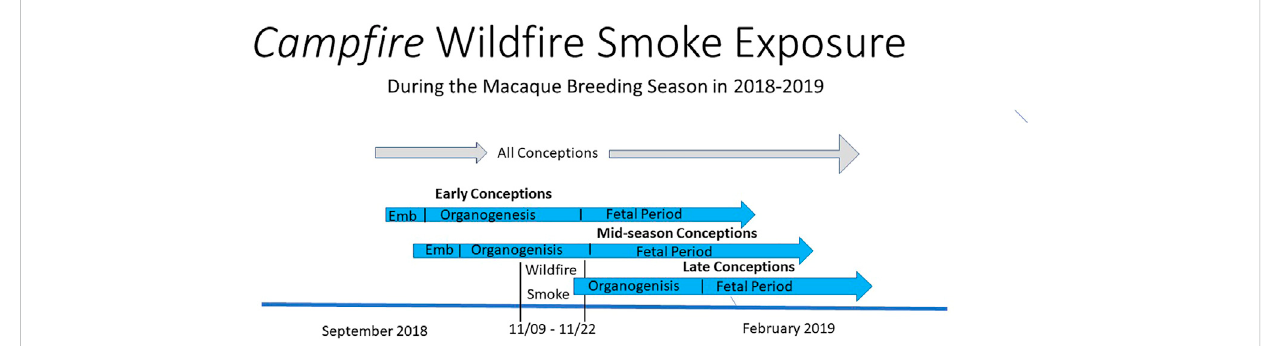
FIGURE 1 Timeline for the gestation periods: gestation periods and wild fi re smoke exposure for the outdoor breeding colony during the Camp fi re wild fi re in 2018. Affected neonates comprised the “ early ” and “ mid ” season conceptions that occurred prior to 11/22. Smoke exposure misses the period of organogenesis where those conceptions occurred in the “ late ” breeding season after 11/22. Organogenesis ends at the end of the fi rst half of gestation and includes the stage of gestation when birth defects are usually induced. Emb, embryonic period.